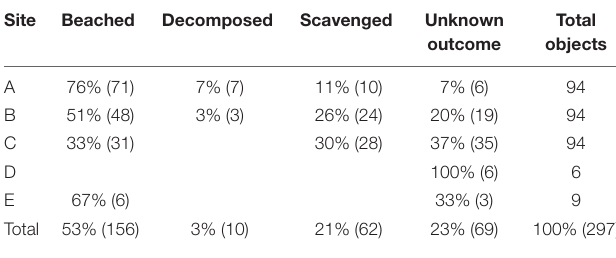
TABLE 2 | Final outcomes of sea turtle carcasses and effigies deployed at sites A, B, C, D, and E in the northern Gulf of Mexico during 2017.